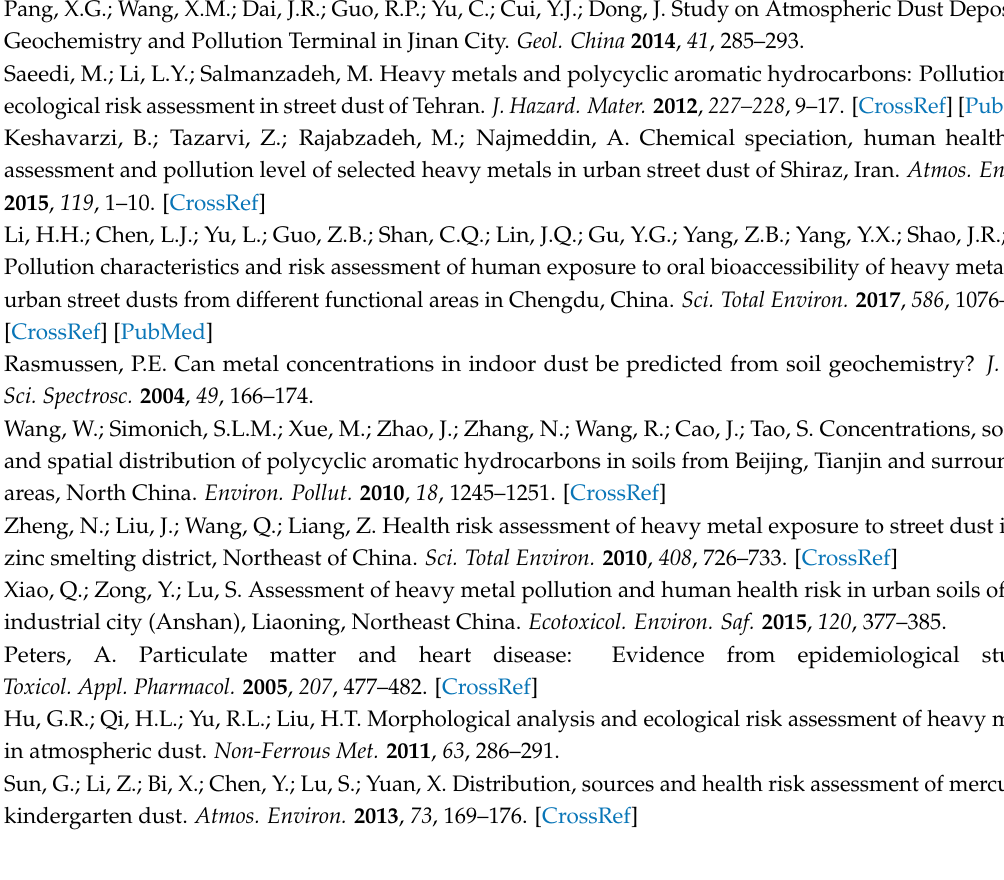
Table S1: Standard substance quality control, Table S2: Pollution evaluation criteria of Enrichment factor, Table S3: parameters of heavy metals, Table S5: Reference doses of heavy metals in different ways of exposure (RfD) Table S7: Health risks of heavy metals in settled